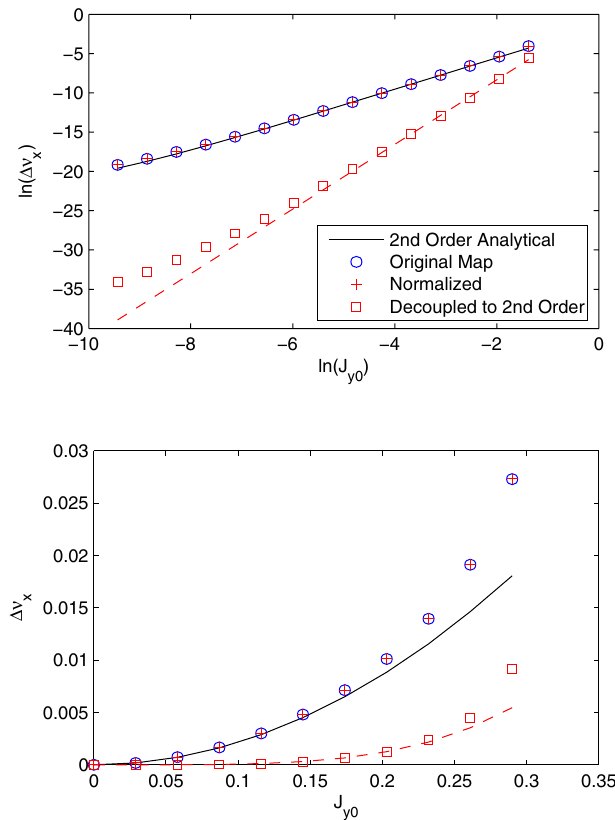
FIG. 2. (Color) Effect of nonlinear decoupling on horizontal tune shift with vertical amplitude. Top: logarithmic scales. Bottom: linear scales. The black line shows the analytical estimate of the tune shift from Eq. (8). The blue points show the result of a Fourier analysis of numerical mapping data, using the map of Eq. (7). Applying the turn-independent normalization Eq. (5) to the mapping data and then repeating the Fourier analysis gives the points shown by red crosses. Finally, applying the turn-dependent transformation Eq. (7) in addition to the turn- independent transformation gives the points shown as red squares. A fit to the final set of points (a straight line on the logarithmic plot) is shown as a broken red